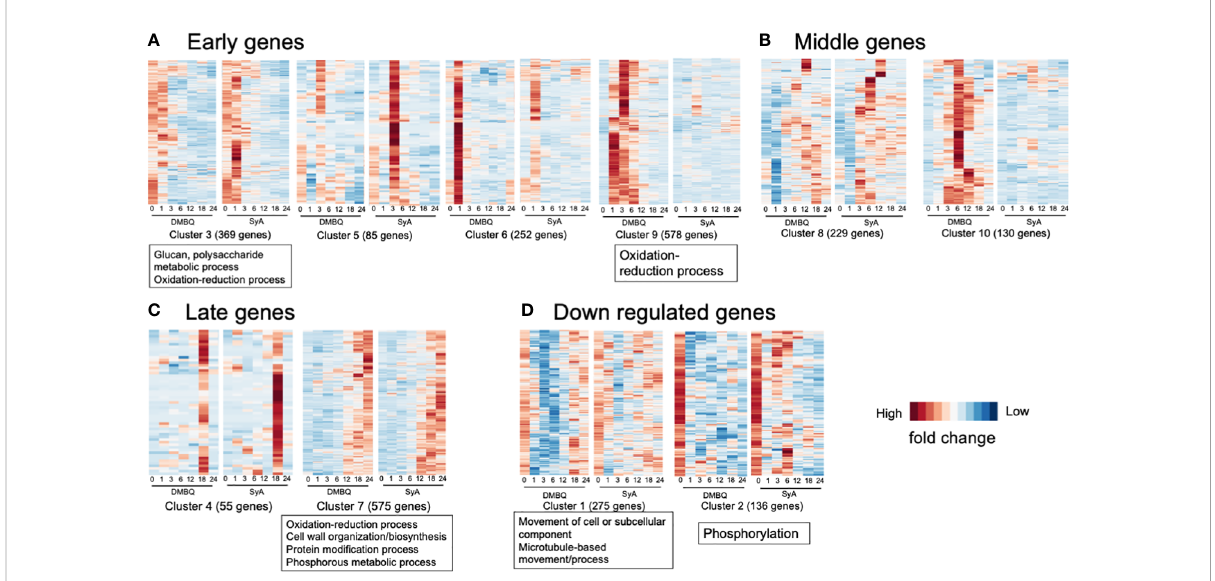
FIGURE 6 Clusters and GO terms for genes expressed at the early, middle and late stages of prehaustorium formation. (A) Clusters displaying genes differentially induced at 1 or 3 h after treatment of DMBQ or syringic acid. (B) Clusters displaying genes differentially induced at least at 6 or 12 h after treatment of DMBQ or syringic acid. (C) Clusters displaying genes differentially induced at least at 18 or 24 h after treatment of DMBQ or syringic acid. (D) Clusters displaying genes downregulated after treatment of DMBQ or syringic acid. Representative enriched GO terms for each cluster are shown in squares under